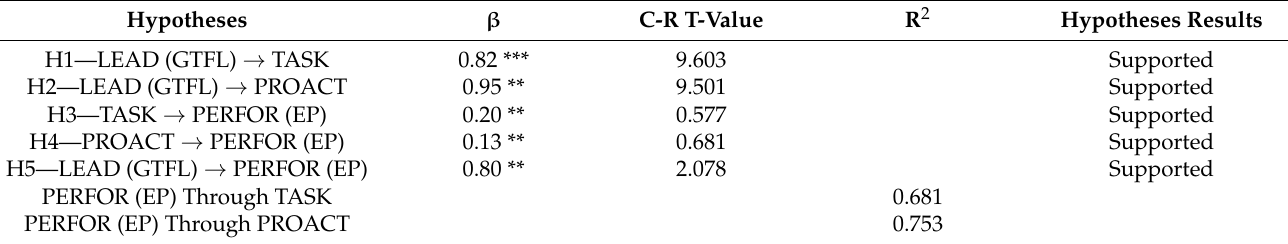
Table 4. Testing the Research Hypotheses.